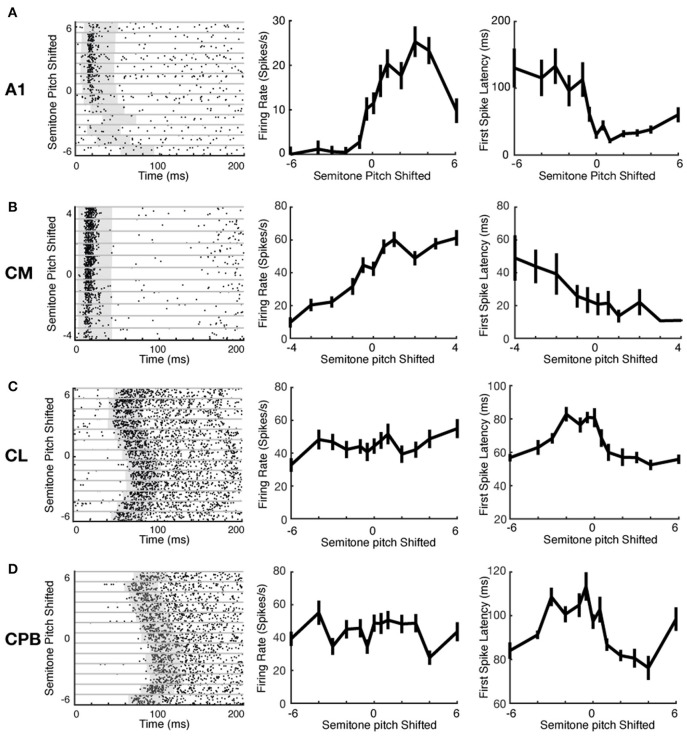
Example neuronal response raster plots and tuning curves to vocalization pitch changes. (A–D) Exemplar unit response to vocalization pitch changes. Label beside each row indicates the cortical areas from which the exemplar neuron was recorded. Left column: Exemplar unit response raster plots. Gray horizontal lines separate responses to different pitch token. Gray box indicates the time window used to calculate the response duration. Middle column: Tuning curves based on firing rate changes with pitch changes for the exemplar units for each area. Left column: Tuning curves based on changes in first spike-latency with pitch changes for the exemplar units for each area. A1 example was from response to Egg; CM example was form response to Egg; CL example was from response to Tsik; and CPB example was from response to Tsik.